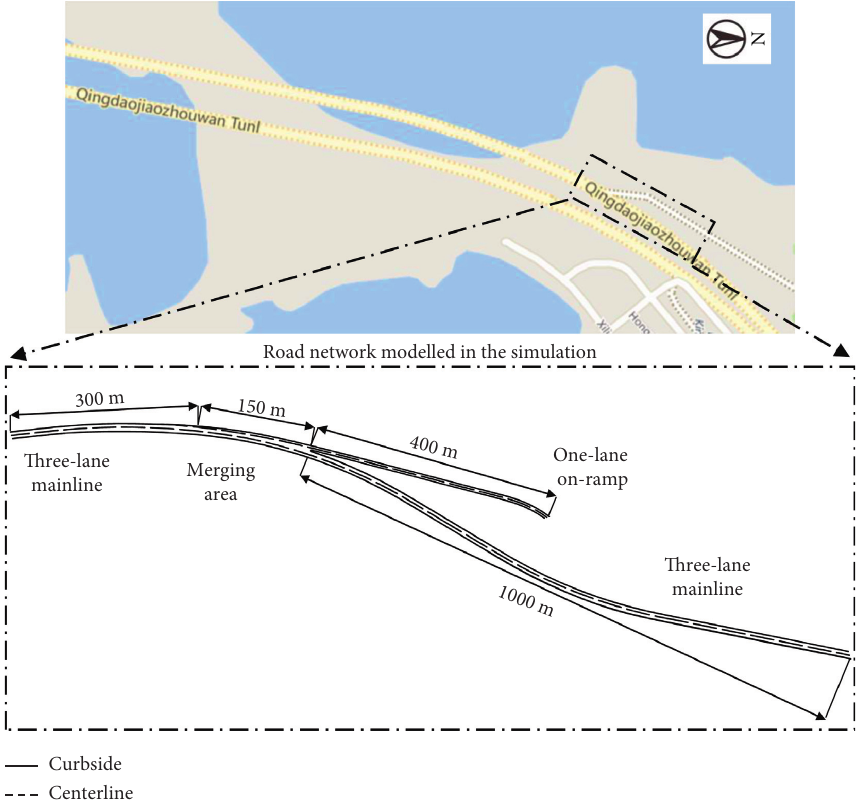
Figure 5: Road network considered in the case study.